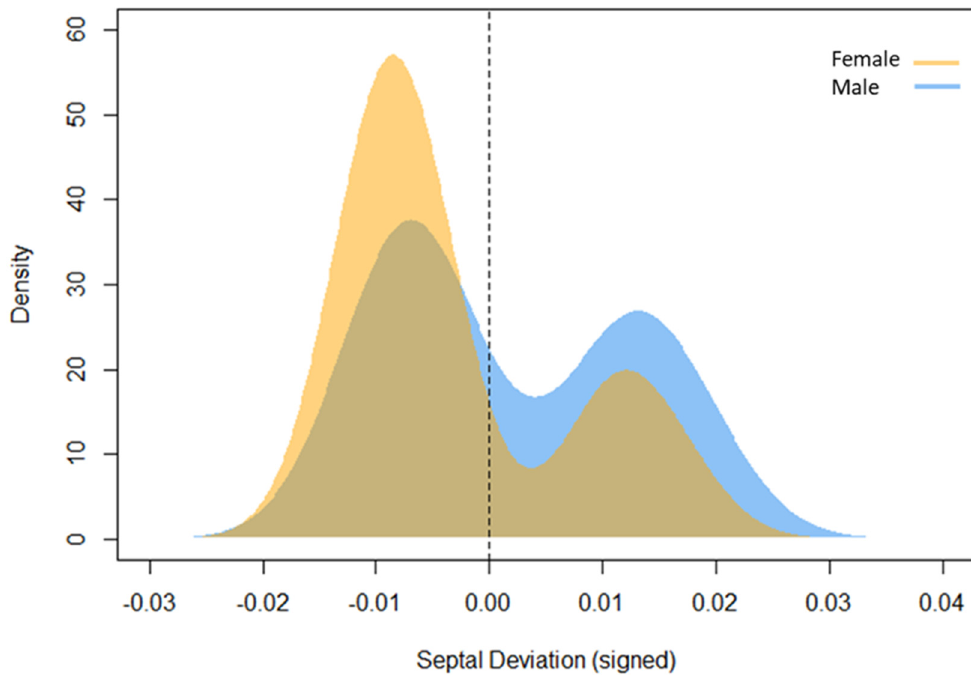
Figure 4. Density distribution plot showing septal deviation in males and females. Along the x -axis, negative values indicate left septal deviation; positive values indicate right septal deviation. The y -axis represents density of septal deviation values. Colours indicate female sample ( orange ) and male sample ( light blue ). Vertical dotted line indicates the zero (absence of septal deviation). Sample size: 46